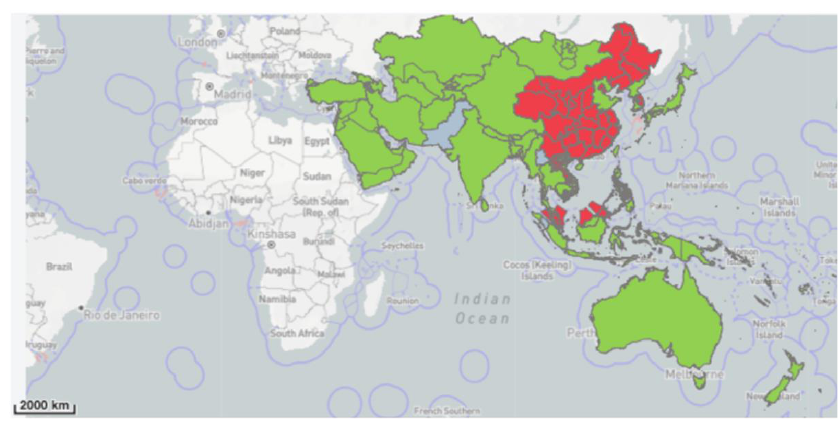
Figure 1. African Swine Fever cases in wild suids reported to the World Animal Health Information System, red shaded regions representing African swine fever is present and green representing absent [41].